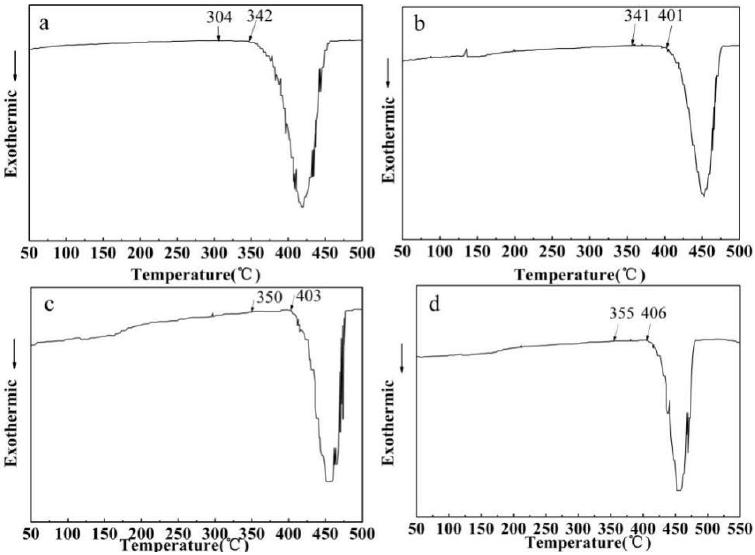
Figure 3. Differential scanning calorimetry (DSC) of the TA–Si x filler metals during the crystallization process: ( a ) x = 0%; ( b ) x = 0.5%; ( c ) x = 1.0%; ( d ) x = 2.0%.